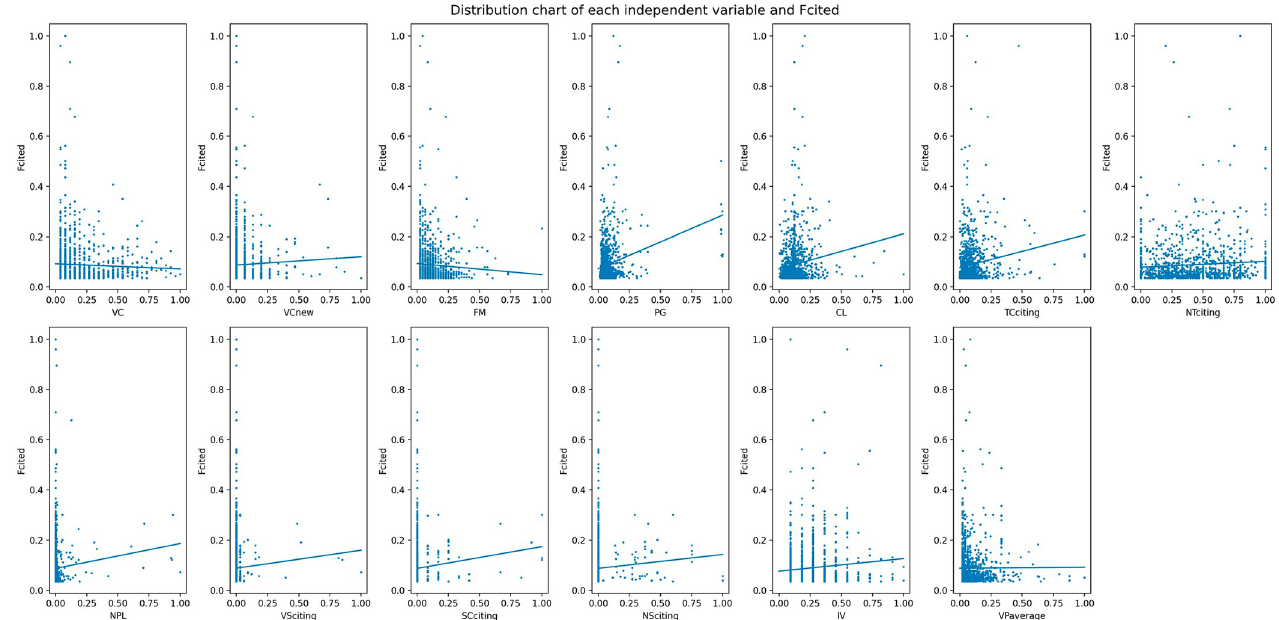
Fig 6. Relationships between each of the explanatory variables and Fcited